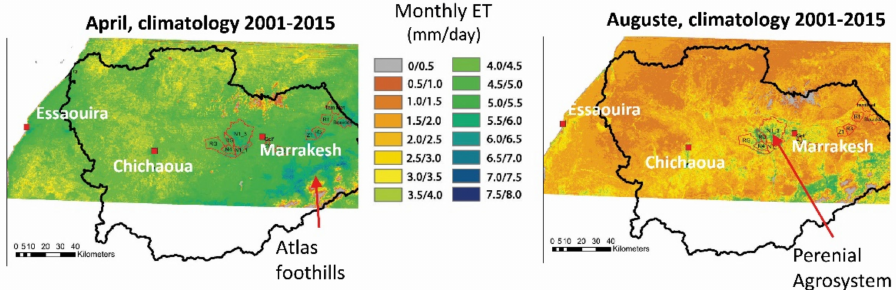
Figure 8. Monthly evapotranspiration climatology (2001–2015) on the Haouz plain for April ( a ) and for August ( b ). The main irrigated perimeters of the plain were superimposed for